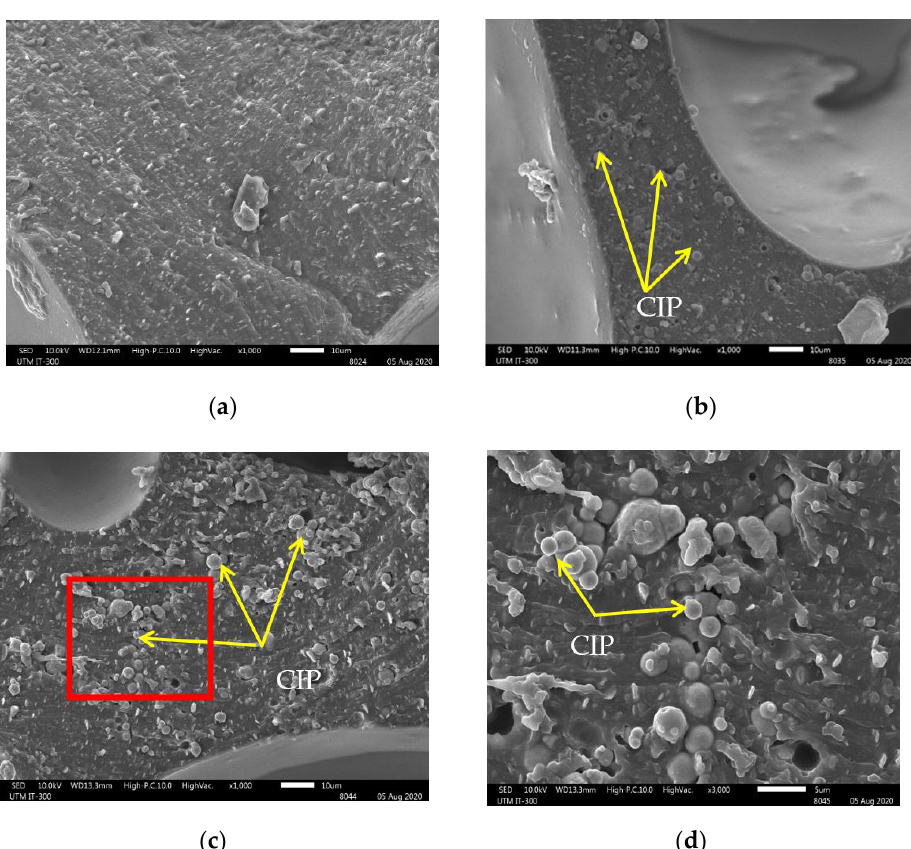
Figure 10. SEM images with magnification 1000 × of strut of ( a ) PU foam, ( b ) 55 wt.%, ( c ) 75 wt.% of MA foams and ( d ) extrapolated with magnification 3000× from the red box in ( c ).